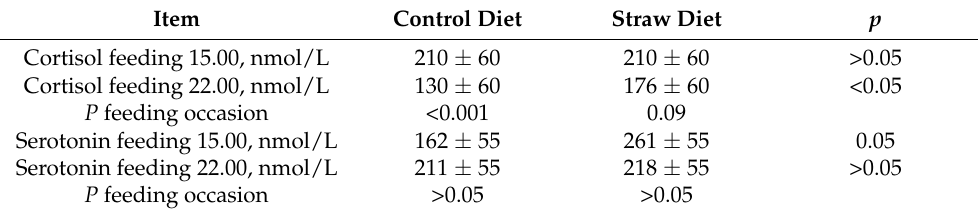
Table 5. Plasma cortisol and serotonin concentrations (LSmeans ± SE) during feeding at 15.00 and at 22.00 in six horses fed a control diet of grass haylage only and a diet with 50% wheat straw and 50% grass haylage (of DM) in a 2 × 21-day cross-over design. Results shown as a mean from blood samples collected before, 90 and 120 min after